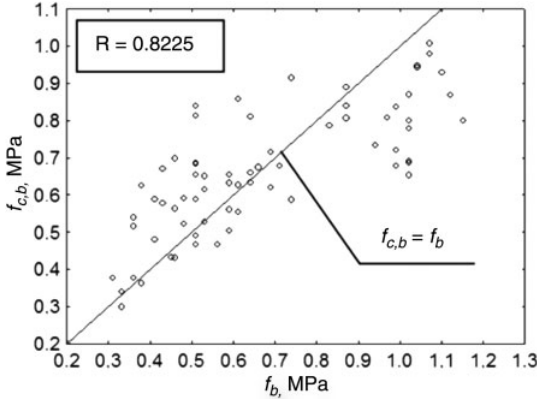
Fig. 17. Dependence between experimentally determined pull-off adhesion f b and pull-off adhesion f c , b identified by neural network during its